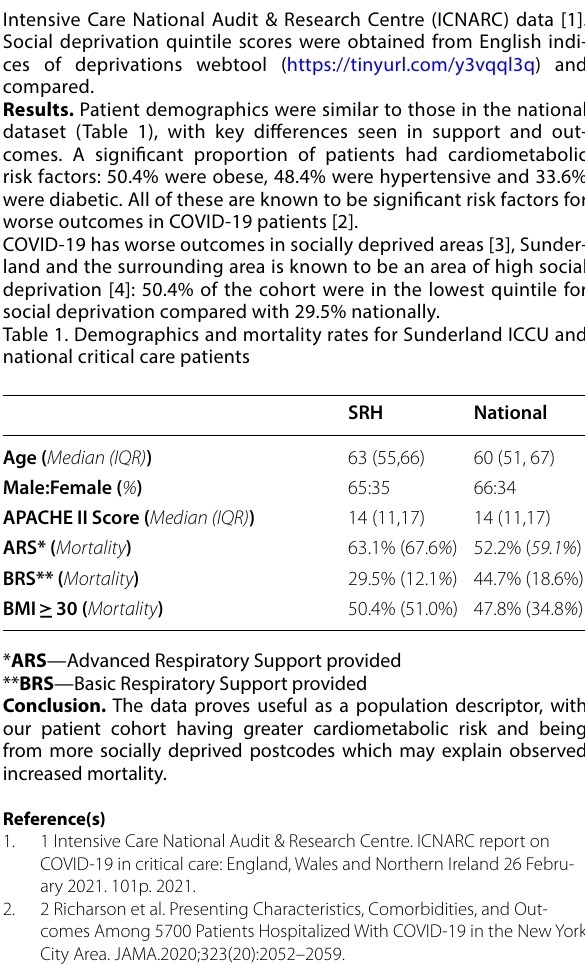
Table 1. Mortality outcome Conclusion. -1–60% of patients were eligible for TOC. Of those, 88% received TOC within 24 h of admission -2- High PCT was the main reason for not being eligible for TOC -3-Conducting two PDSA cycles including education and modifying the handover sheets assisted in reaching our target -4-MDT approach supported the effective imple- mentation of a new line of treatment during a difficult pandemic time.